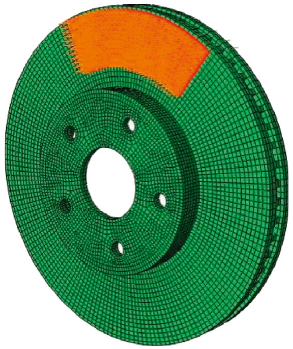
Figure 7: Input heat flow load.